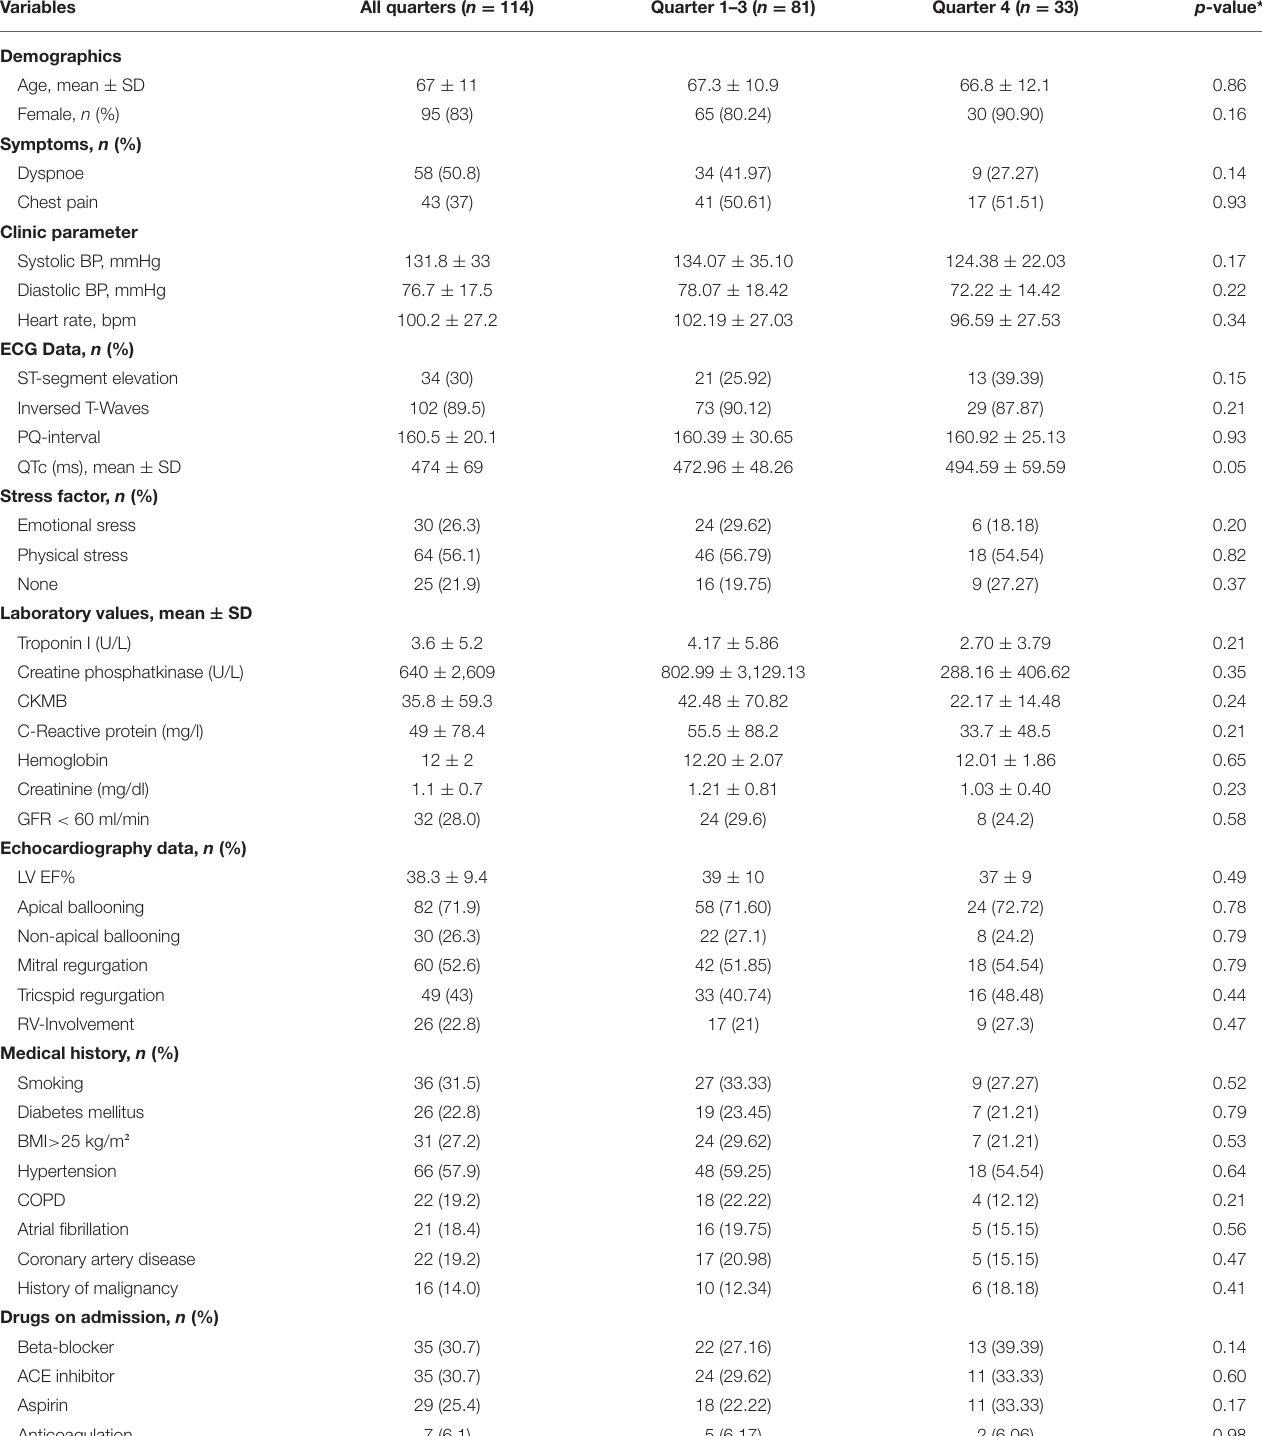
TABLE 1 | Baseline characteristics of patients presenting with TTS in the fourth quarter of year.